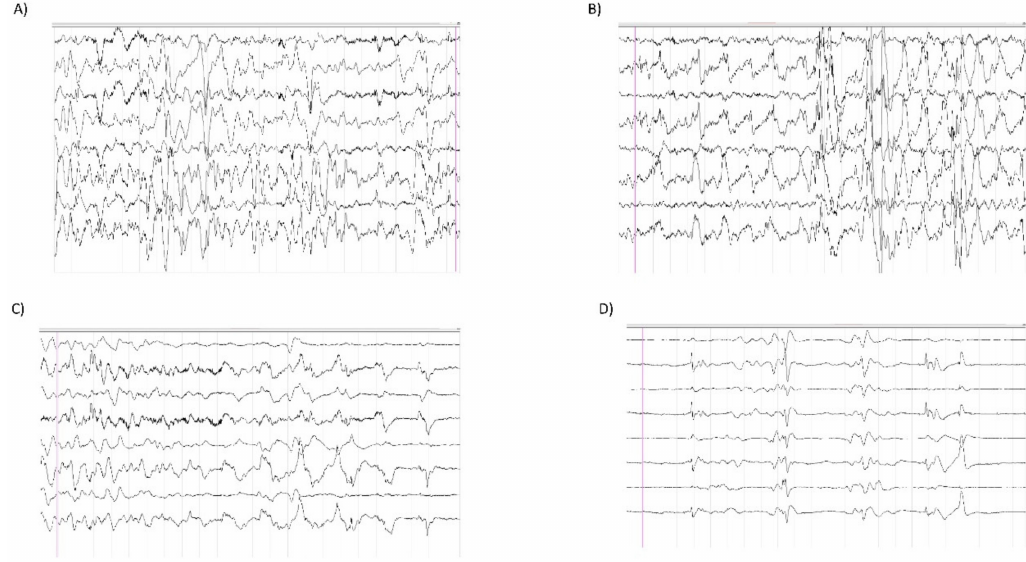
Figure 2. Electroencephalography (EEG). ( A , B ) High voltage slow waves from right occipital areas with bilateral involvement. Video EEG recording showed associated chaotic movements. ( C , D ) Occipital bilateral slow waves with suppression of electrical activity. Video EEG recording showed apnea and lack of